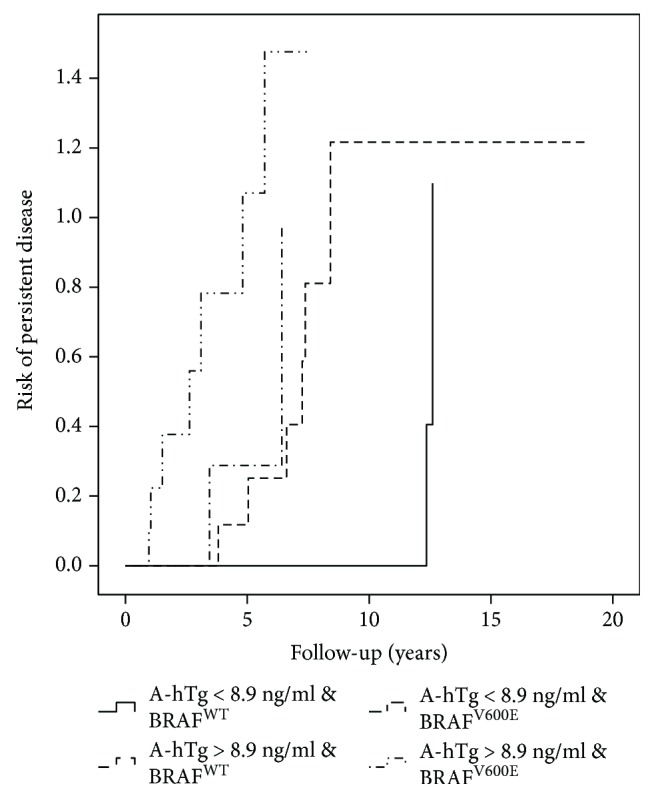
A-hTg and BRAF mutation predict persistent disease in the high-risk ATA classification.